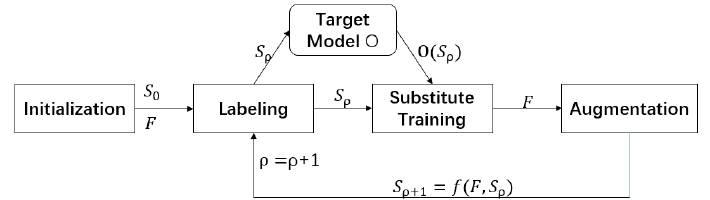
Figure 1. Flowchart of Substitute Training [15]. This pattern mainly contains four steps: Initialization, Labeling, Substitute Training and Augmentation. The adversaries label and augment the dataset repeatedly for training substitute models that fit the target model’s decision boundary better and better. augmenting function f